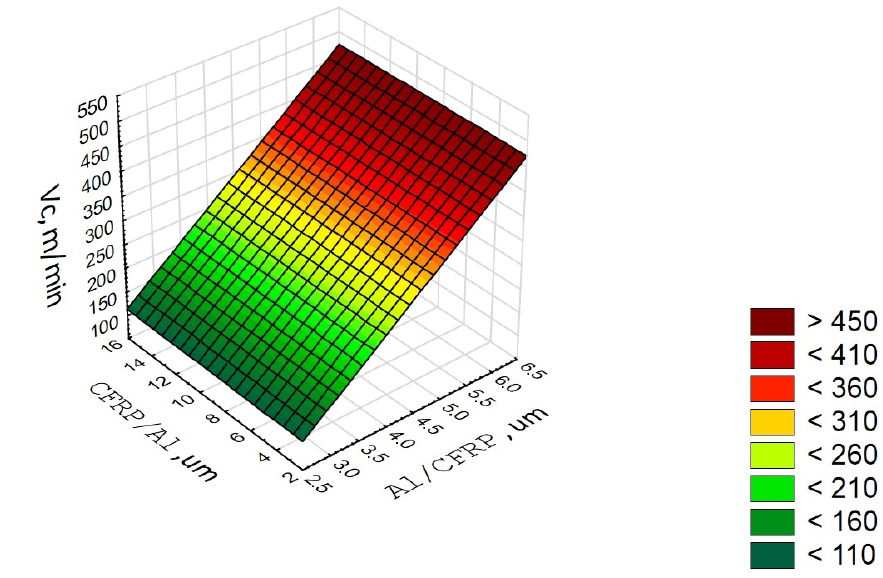
Figure 10. Diagram of correlation and multiple regression for V c parameter.